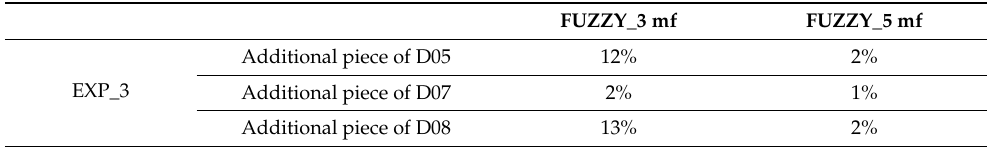
Table 13. Relative errors among defuzzified values and the values obtained through an analytical model to assess increment in redundancy